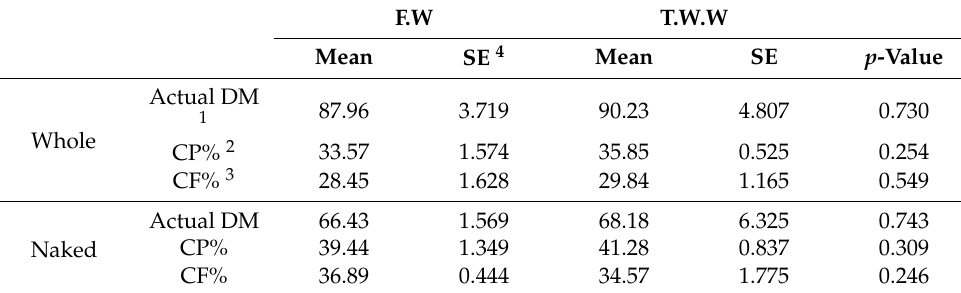
Table 4. Effect of using TWW and FW on seed proximate